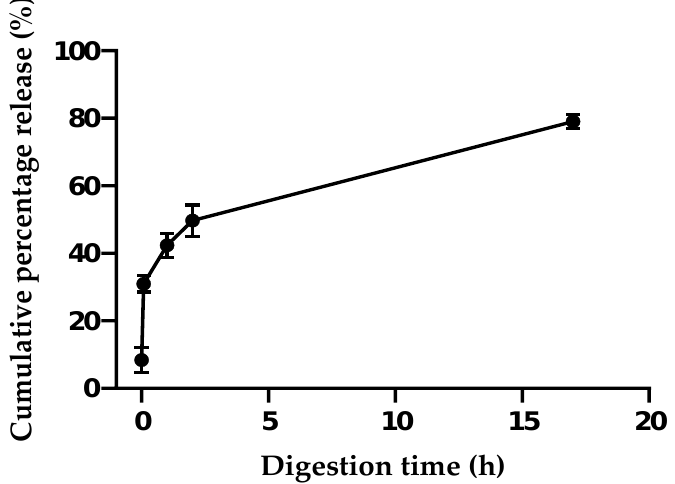
Figure 4. Release of PGA-Cy5 (PC) conjugate during in vitro static digestion.